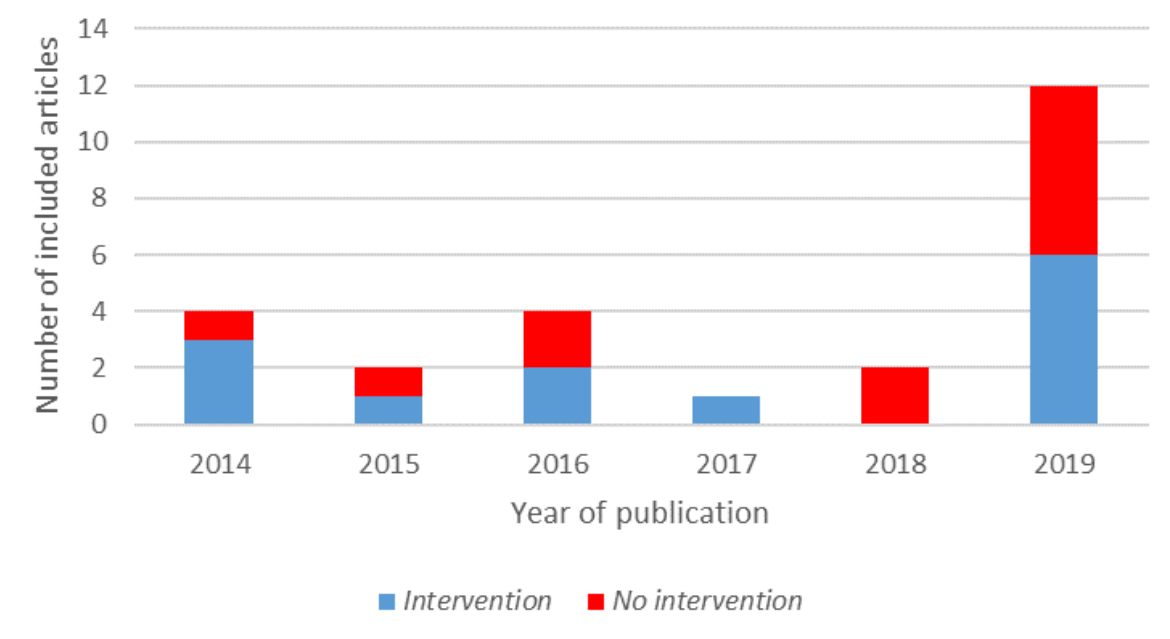
Figure 2. Number of included articles by year of publication and presence of an intervention.